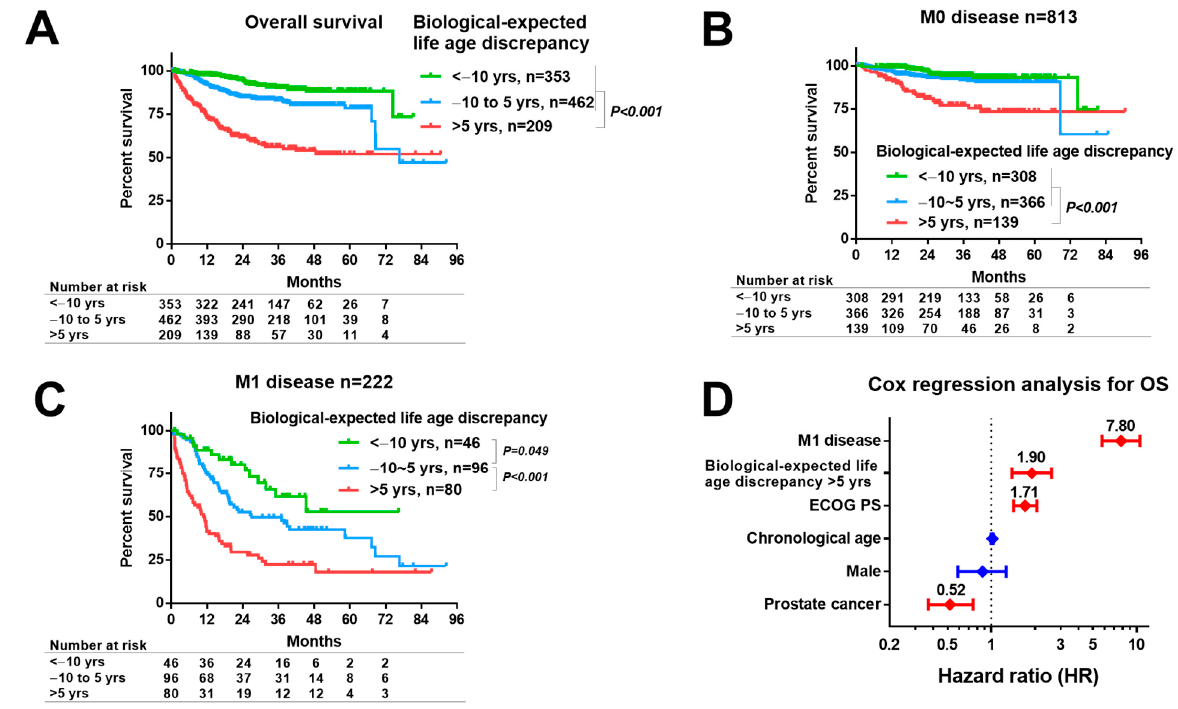
Figure 3. Secondary outcomes. ( A ) The OS comparison of age discrepancy among patients with urological cancers. ( B ) The OS comparison of age discrepancy among patients with urological cancers in the nonmetastatic (M0) disease groups. ( C ) The OS comparison of age discrepancy among patients with urological cancers in the metastatic (M1) disease groups. ( D ) Hazard ratio (HR) of multivariable Cox regression analysis to test the association of age discrepancy on OS.